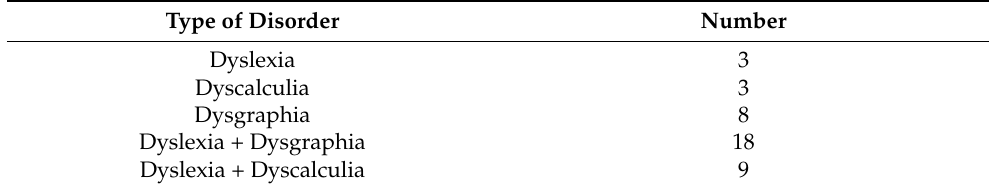
Table 2. Number of children with specific learning disorders by type of